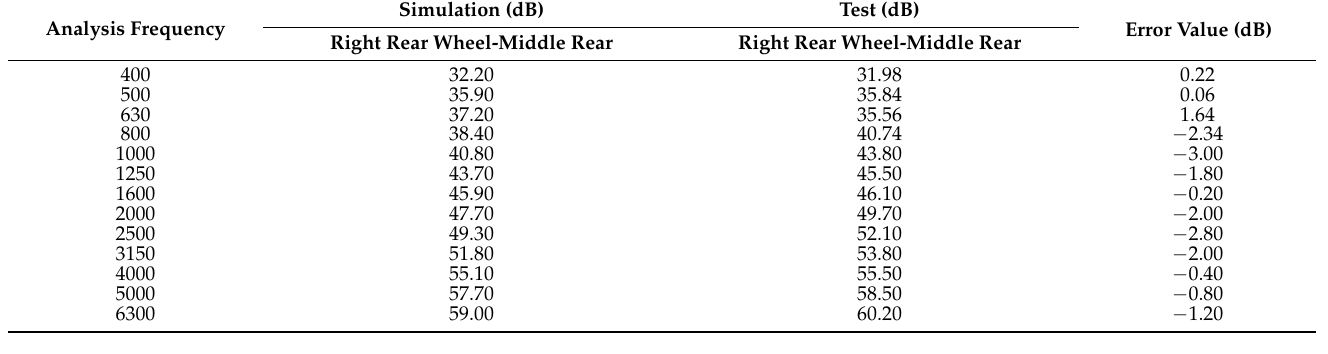
Table 8. Right rear wheel excitation test results.